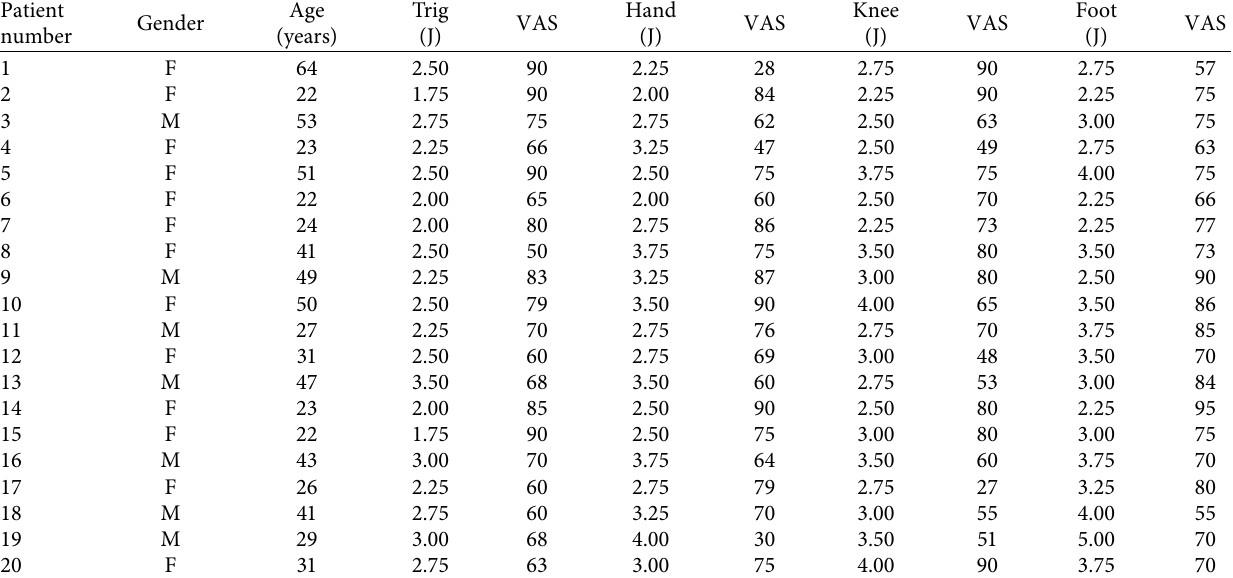
Table 1: Pain thresholds for a-delta fbers modality of stimulation.